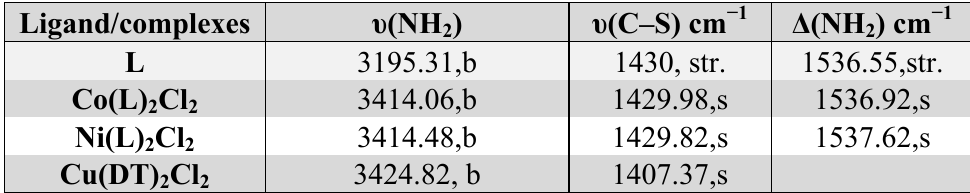
Table 2. IR spectral assignment of L and its metal complexes.